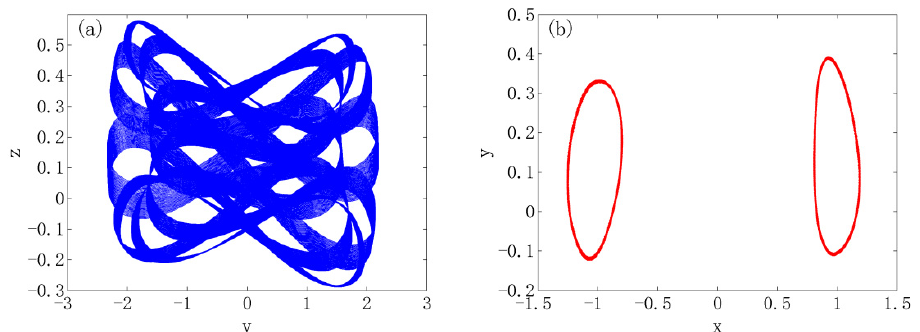
α= . ( a ) Phase trajectory dia- xz plane.